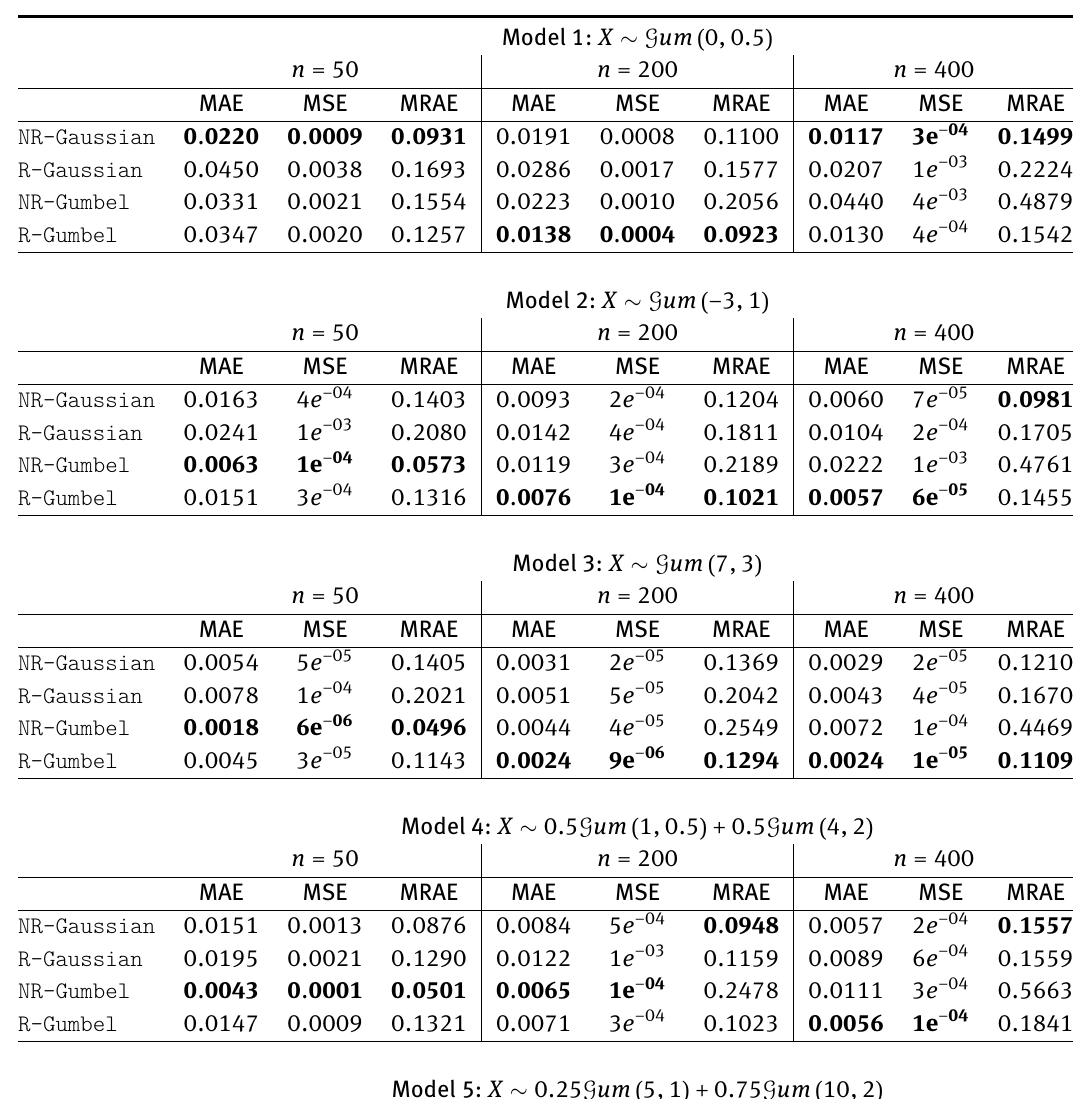
Table 1: Quantitative comparison between the four considered methods. The bold values indicate the smallest values regarding the MAE , MSE and MRAE